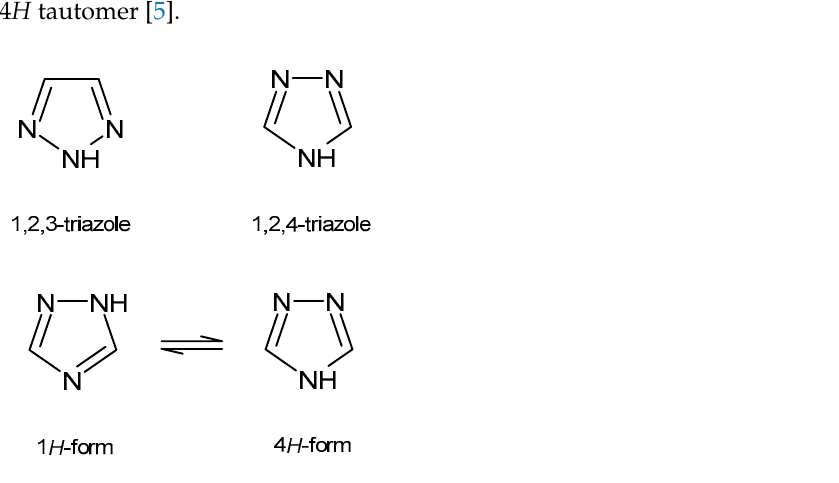
Figure 1. Two isomeric forms of triazole and tautomeric forms of 1,2,4-triazole.